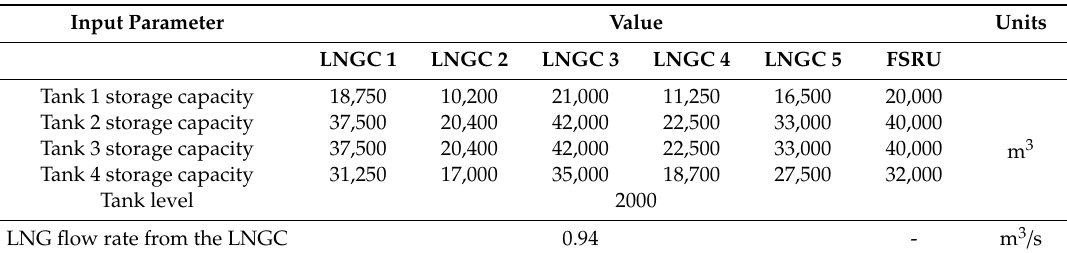
Table 3. Parameters for scenarios 4, 5 and